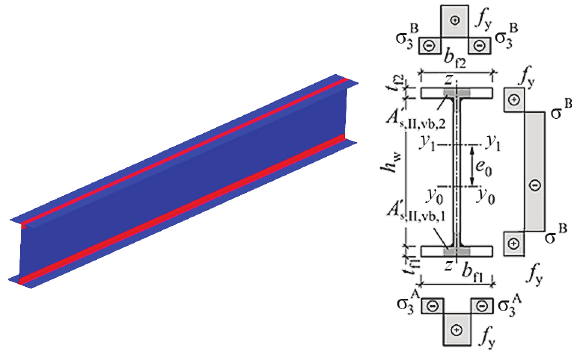
Fig. 14. Longitudinal welding stresses used in numerical simulations